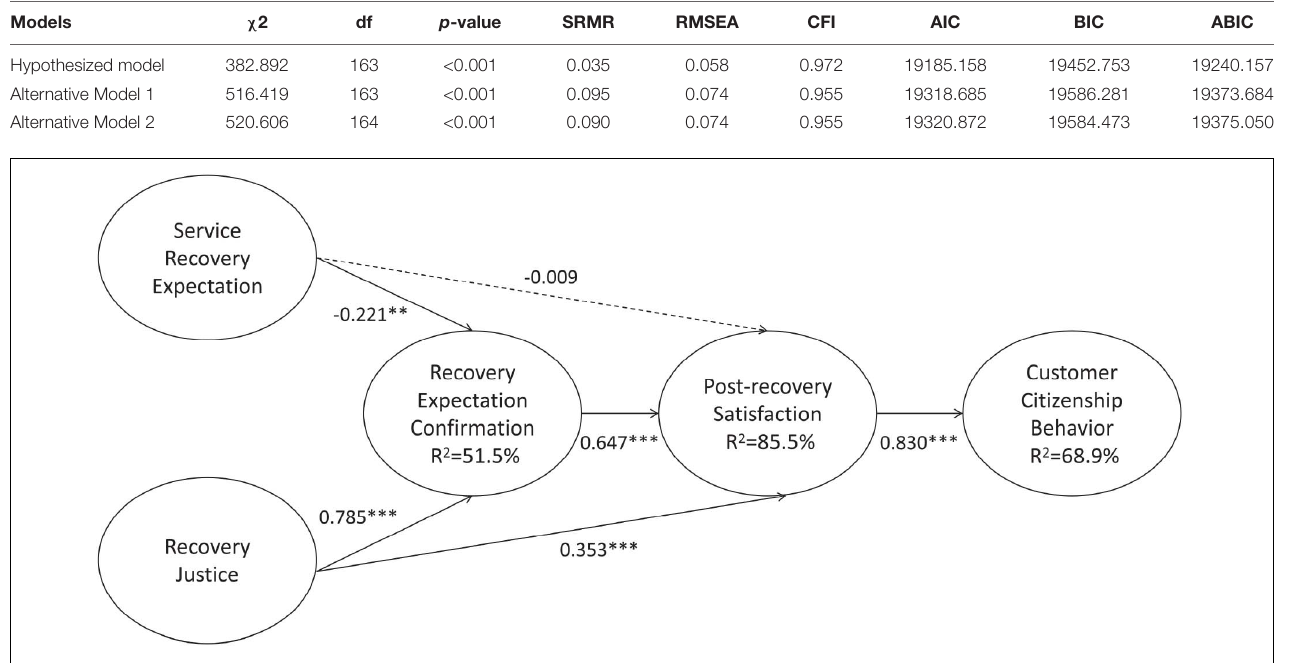
Frontiers in Psychology |